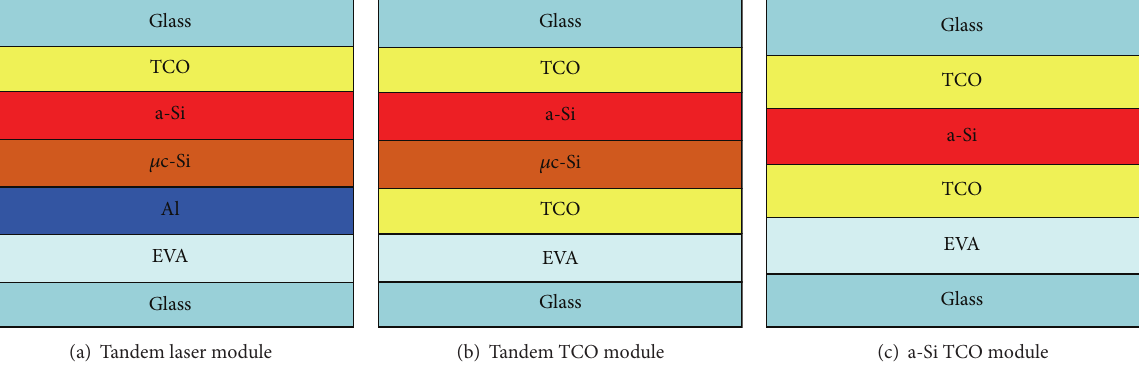
Figure 2: Cell structure of the tandem laser, tandem TCO, and a-Si TCO